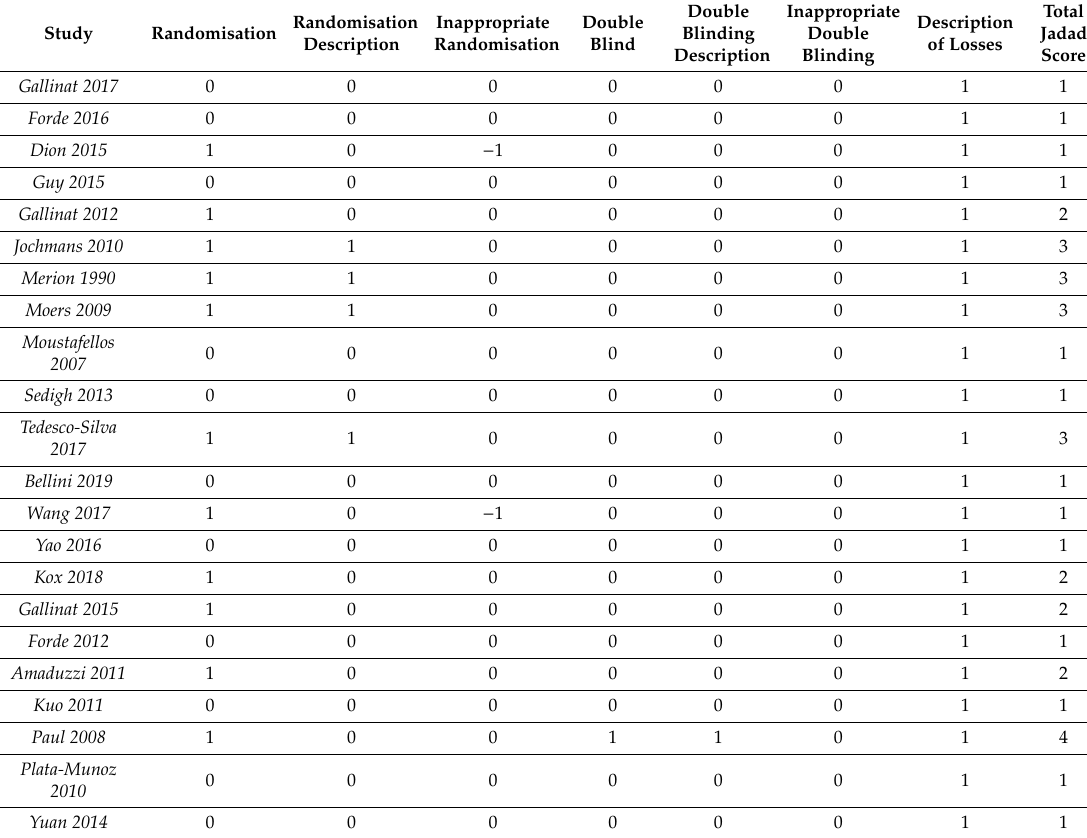
Table 5. Risk of bias assessment of studies comparing HMP and SCS preservation in kidney.